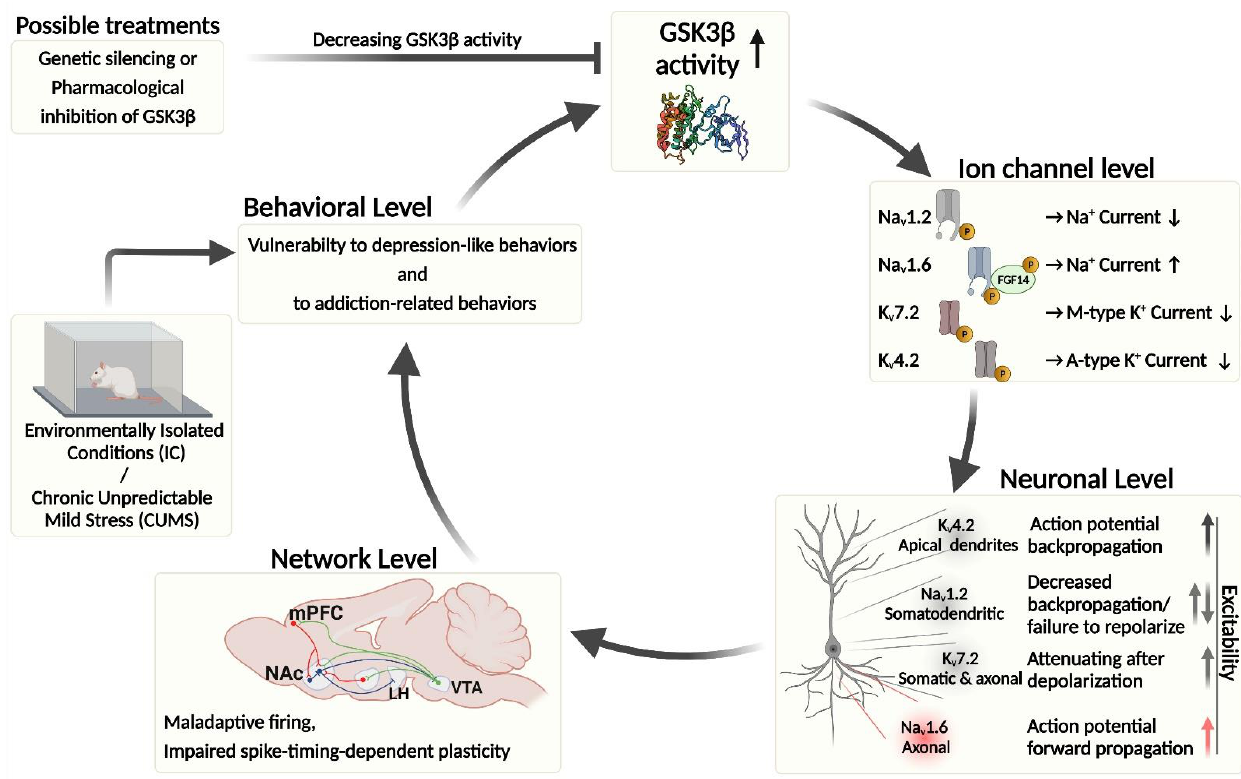
Figure 2. Summary of GSK3 β activity on Nav channels/complexes (Na v 1.2 and Na v 1.6/FGF14) and K v channels (K v 7.2 and K v 4.2) and possible outcomes at the cellular, network, and behavioral levels. Increased activity of GSK3 β causes decreased Na + and K + currents via Na v 1.2 and K v 7.2/K v 4.2 channels, respectively, while increasing Na + influx via the Na v 1.6 complex. At the neuronal level, in- creased activity of GSK3 β leads to increased action potential forward and backward propagation via modulation of Na v 1.6 and K v 4.2 activity, respectively. It can also attenuate action potential repolariza- tion via K v 7.2 and lead to paradoxical increase in excitability via suppression of Na v 1.2. Additionally, suppression of Na v 1.2 induced by increased activity of GSK3 β can also diminish action potential